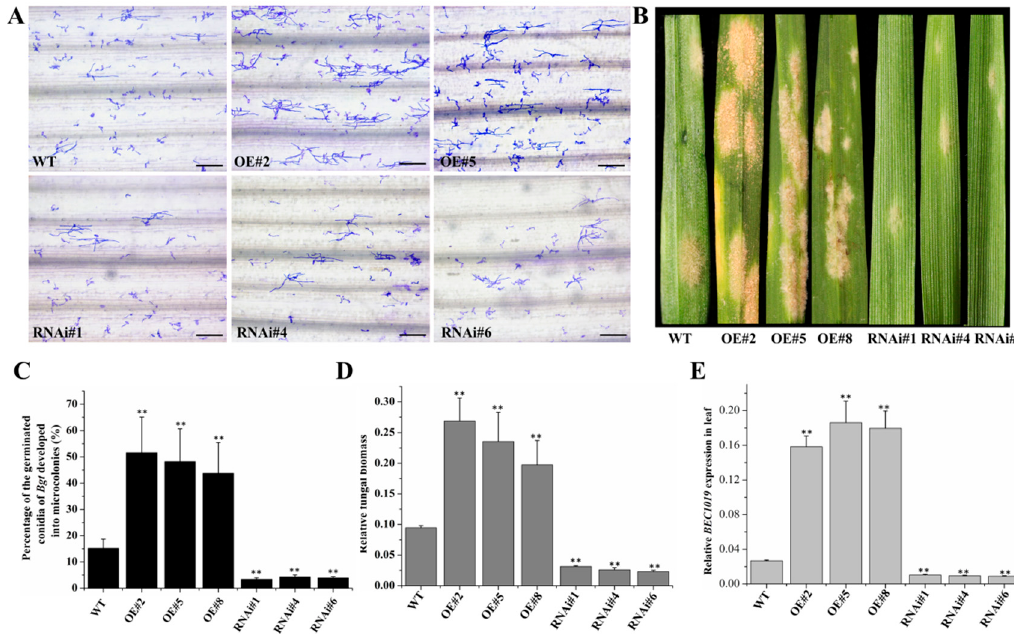
Figure 3. Overexpression of BEC1019 in Aikang 58 wheat enhanced the susceptibility of plants to wheat powdery mildew Blumeria graminis f. sp. tritici ( Bgt ), whereas silencing BEC1019 increased resistance to Bgt . ( A ) Microscopic analysis revealed Bgt microcolony formation on the leaves of control plants and BEC1019 -overexpressing and RNAi plants at 60 h post-inoculation (hpi). Scale bar = 25 µm. ( B ) Macroscopic phenotypes of Bgt infection on wild-type control plant leaves and BEC1019 -overexpressing and RNAi plant leaves. ( C ) Percentages of germinated Bgt conidia on the BEC1019 -overexpressing and RNAi plants and control plants at 60 hpi. ( D ) Quantification of Bgt fungal biomass in control wheat and BEC1019 -overexpressing and RNAi plants. ( E ) Transcript levels of BEC1019 in Bgt -infected leaves of overexpressing and RNAi transgenic plants. Double asterisks indicate significant differences relative to control plants ( p ≤ 0.01, according to t -tests).